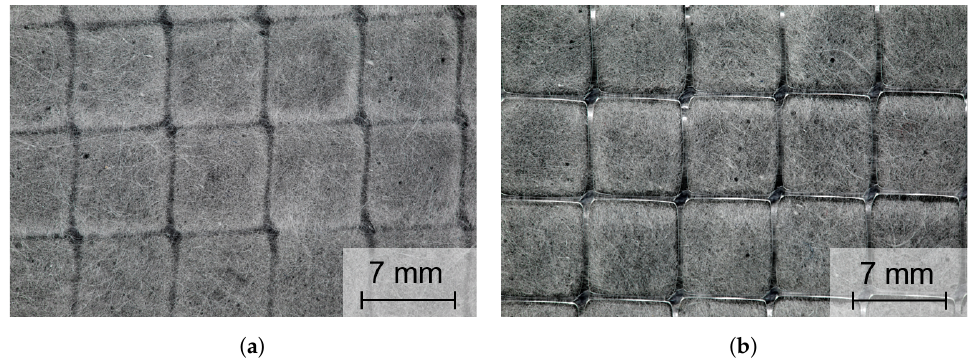
Figure 1. Pictures of the utilized filter material consisting of 80wt.% micro glass fiber and 20wt.% PET fiber with a basis weight of 15gm − 2 . To increase the mechanical stability, the filter material was laid on a wide meshed support structure. ( a ) Filter upstream side. ( b ) Filter downstream